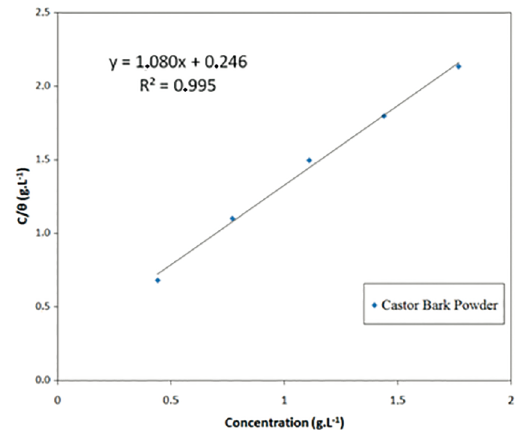
Figure 2. Langmuir adsorption plots for AISI 1020 carbon steel containing different amounts of castor bark powder in HCl 0.5 mol.L -1 . The Gibbs standard free energy of adsorption (ΔG° of -16.92 kJ mol -1 was calculated using Equation